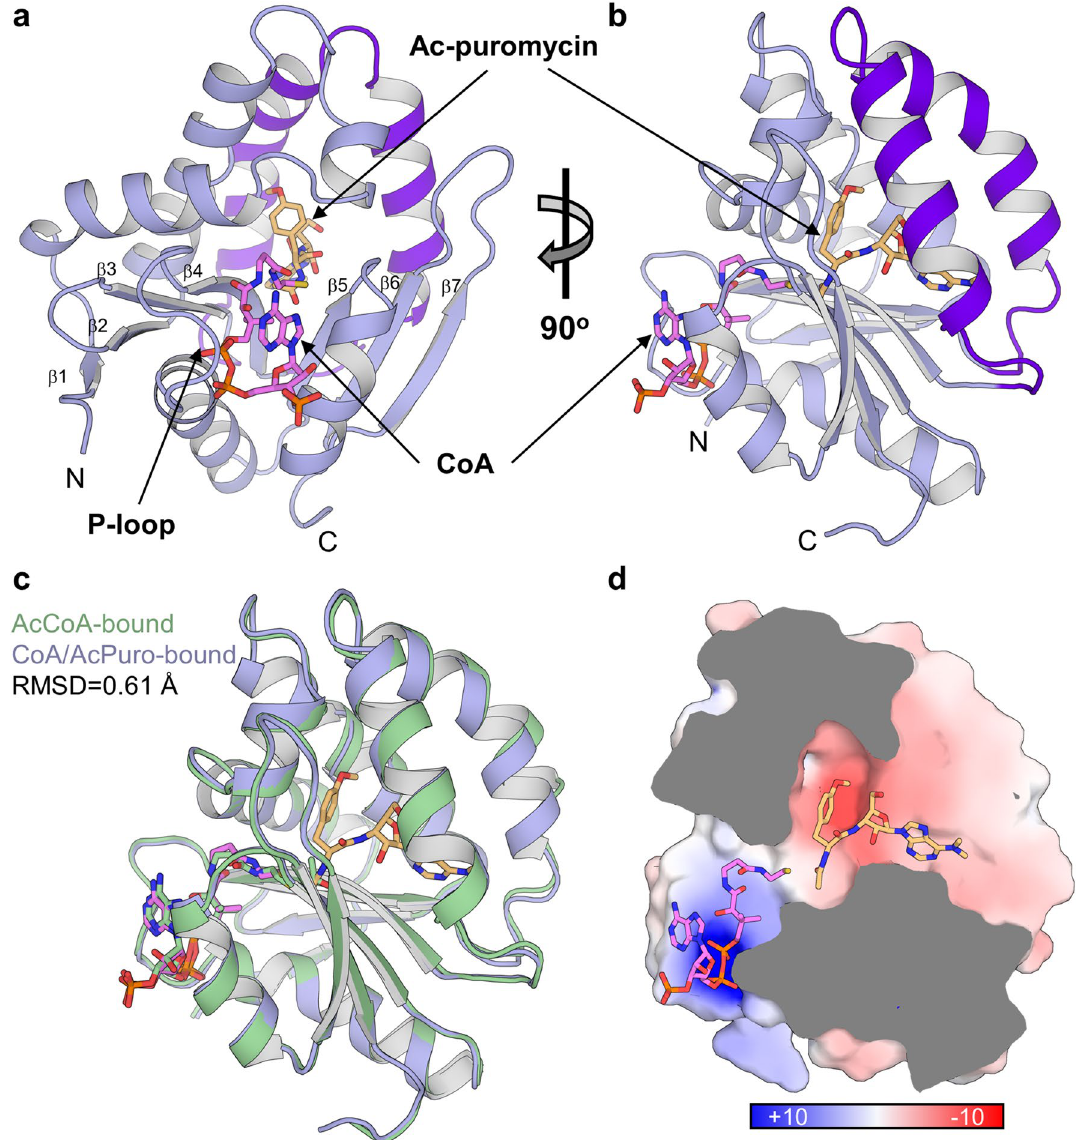
Figure 1. Crystal structures of PAC. ( a , b ) Two orientations of the structure of PAC in complex with the reaction products CoA (pink) and acetylated-puromycin (light orange). The seven β-strands that make up the central sheet of the fold are numbered. The two-helix hairpin insertion unique to PAC is highlighted in dark purple. ( c ) Overlay of the two structures presented in this work with the same representation as ( b ). The green structure represents PAC with AcCoA bound and shows the little deviation in global structure. ( d ) Electrostatic potential mapping onto the surface of PAC calculated using Adaptive Poisson-Boltzmann Solver Tool and pdb2pqr in PyMOL 48,49 . The depiction is of a cross-section of the active site in the same orientation as shown in ( b , c ) and the surface is represented and a scale between − 10 and + 10